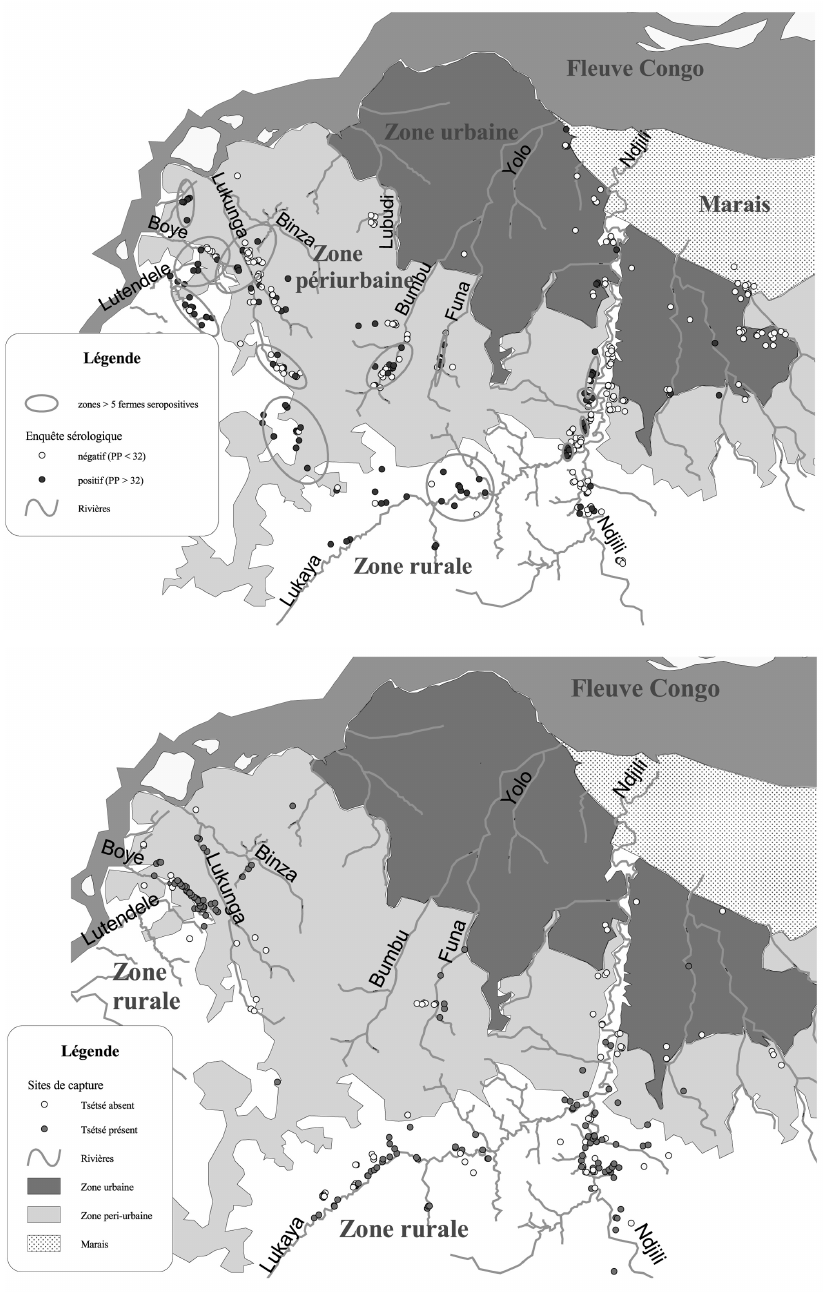
Fig. 3. – Sites où des mouches tsé-tsé ont été capturées près des